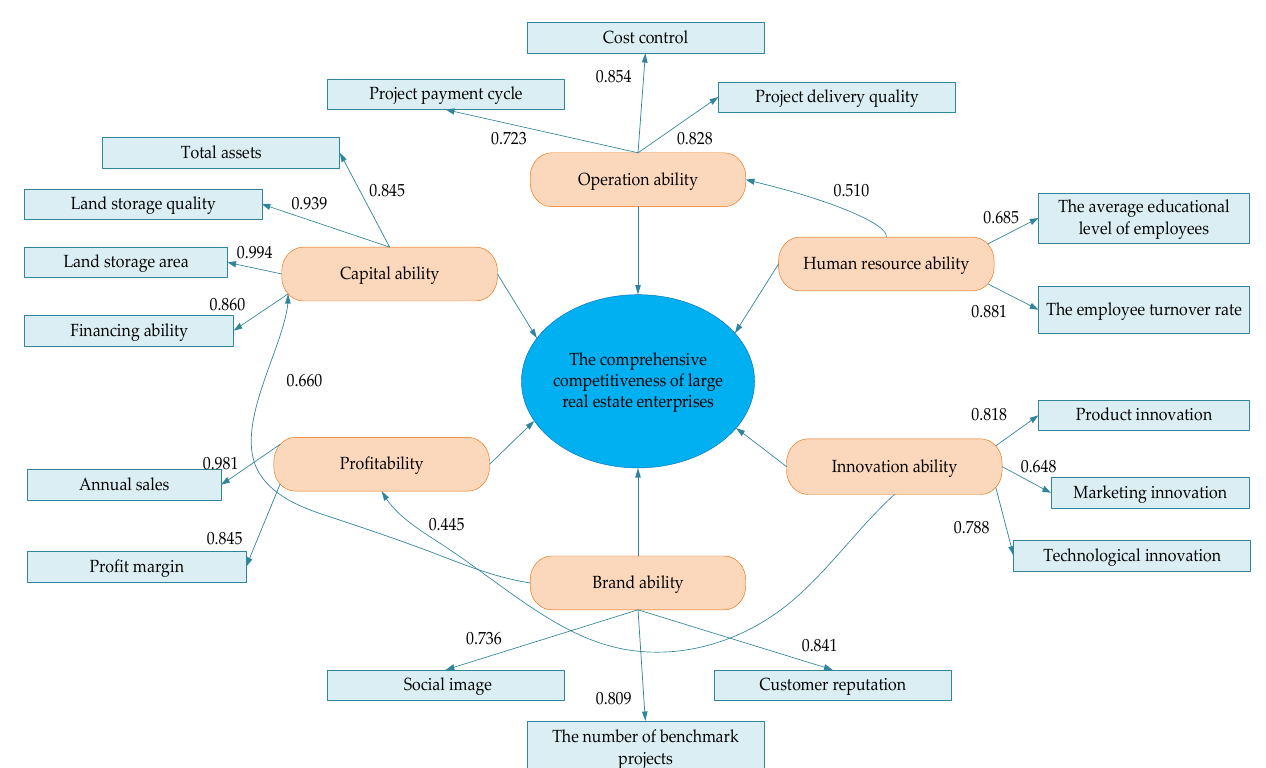
Figure 2. Results of structural equation model for internal factors affecting the comprehensive competitiveness improvement of large real estate enterprises.